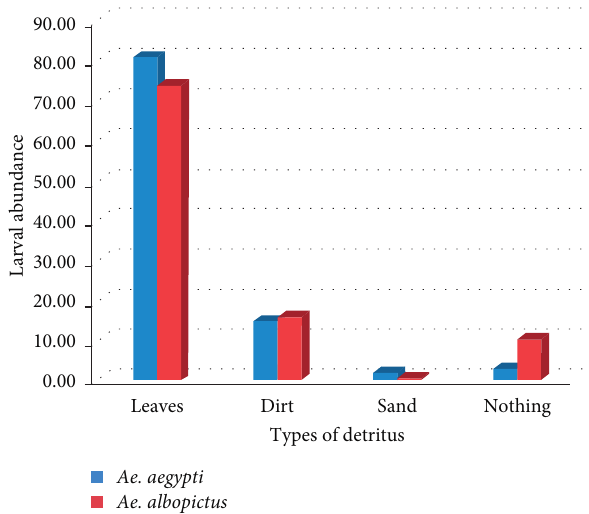
Figure 9: Relative abundance of larvae in containers with different types of